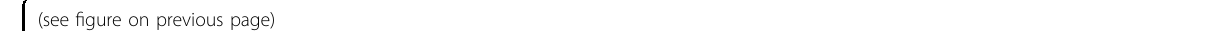
Fig. 5 Intercellular communication changes in HCM cardiac tissues inferred from the snRNA-seq data. a Bar plot showing the total number of ligand-receptor interactions among the subpopulations of the cardiac tissues in both conditions. b Bar plot showing the total interaction strength among the subpopulations of the cardiac tissues in both conditions. The total interaction strength was calculated by summing the communication probability of all inferred interactions. c Heatmap showing the differential number of interactions among subpopulations in HCM versus HEALTHY. In the color bar, red represents an increase in the number of interactions and blue represents a decrease in the number of interactions. The top bar plot shows the sum of the changes in the number of incoming signals for each subpopulation. The right bar plot shows the sum of the changes in the number of outgoing signals for each subpopulation. d Heatmap showing the differential interaction strength among subpopulations in HCM versus HEALTHY. e Bubble plot showing the incoming and outgoing interaction strength for each subpopulation in HCM. The dot size represents the count of interactions. f Bubble plot showing the incoming and outgoing interaction strength for each subpopulation in HEALTHY. g Relative information fl ow for each signaling pathway in both conditions. The information fl ow is de fi ned by the sum of the communication probability among all pairs of subpopulations. h Joint manifold learning of the HCM and HEALTHY communication networks and grouping the signaling pathways based on functional similarity. A high degree of functional similarity means that the major senders and receivers are similar. i The Euclidean distance of each pathway in the learn joint manifold. A larger distance means a larger difference in functional similarity (i.e., similarity in senders and receivers) between the two conditions. Only overlapping pathways between the two conditions are shown. j The major senders and receivers of the TGF β signaling pathway inferred through network centrality analysis in HEALTHY (upper panel) and HCM (lower panel). k Relative contribution of each ligand-receptor pair to the overall signal of the TGF β pathway in HCM. l Hierarchical plot showing the inferred communication network for TGFB1- (TGFBR1 + TGFBR2) signaling in HEALTHY. m Hierarchical plot showing the inferred communication network for TGFB1-(TGFBR1 + TGFBR2) signaling in HCM. In l and m , open and solid circles represent target and source, respectively. Edge width represents the interaction strength and circle size is proportional to the number of nuclei in each subpopulation. Edges are color-coded based on the signal